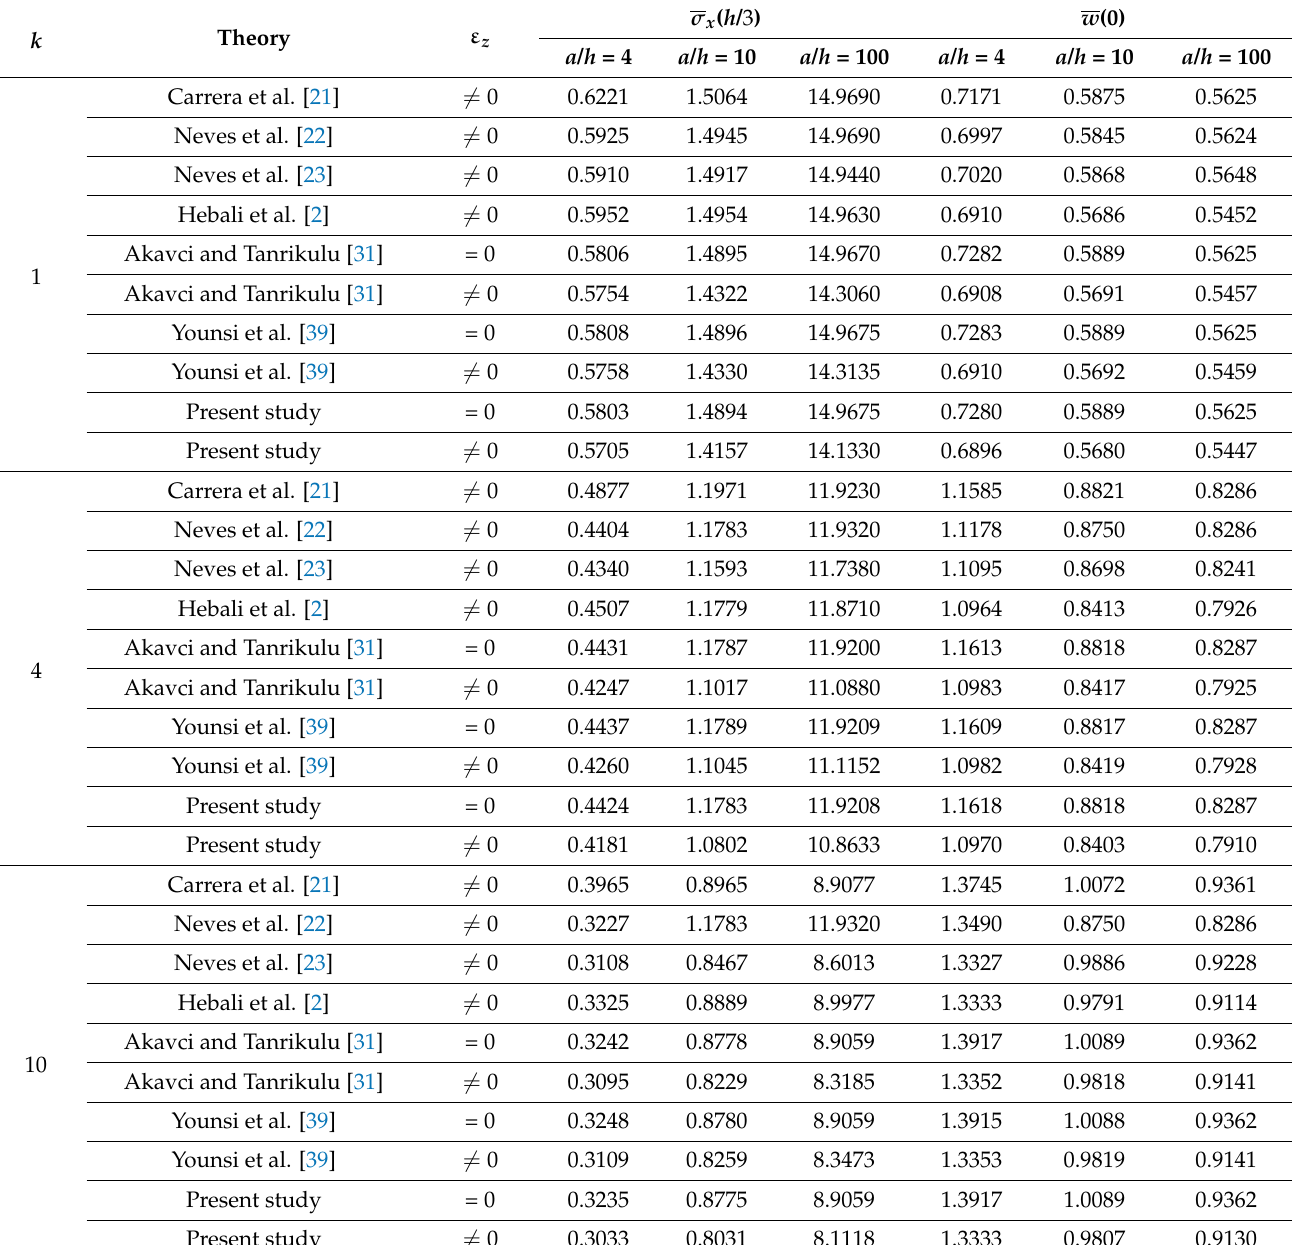
Table 3. Non-dimensional displacement and stress of an Al/Al 2 O 3 FG square plate subjected to sinusoidal